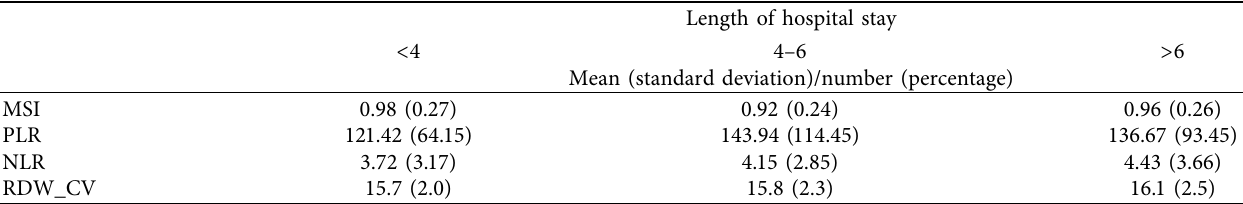
Table 7: Mean ± SD of neutrophil to lymphocyte ratio (NLR), platelets to lymphocyte ratio (PLR), modifed shock index (MSI), and red cell distribution width (RDW) among the tetile of hospitalization time in patients with HFrEF. ∗ signifcant between group diference.